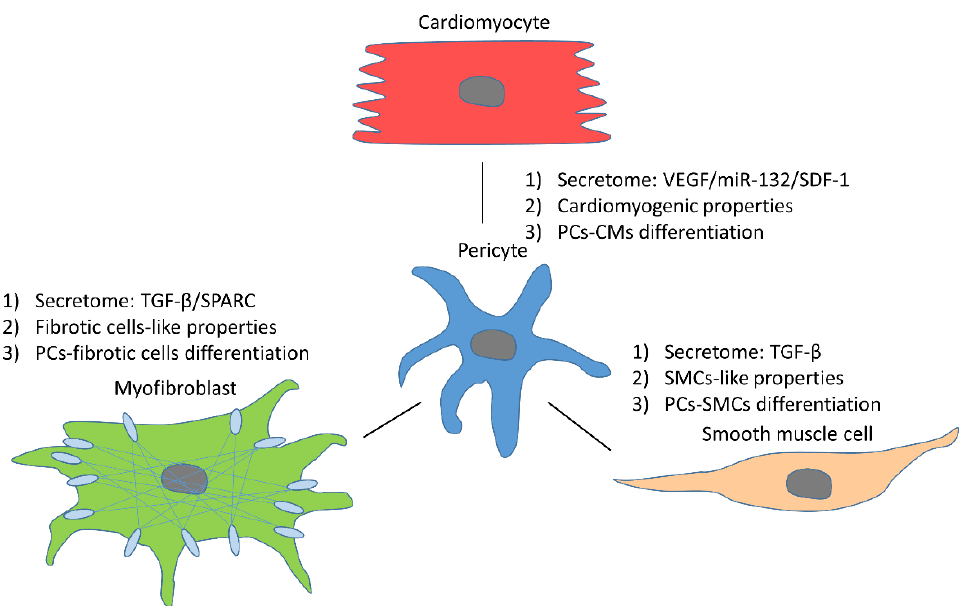
Figure 2. Interactions and differentiation between pericytes and their adjacent cells. ( 1 ) Cardiomyocytes. Through secreting VEGF and miR-132, pericytes could induce survival responses in cardiomyocytes. Moreover, stromal cell-derived factor-1 (SDF-1) from pericytes activates the mobilization of stem cells, benefiting cardiomyogenesis. Furthermore, some pericytes, sharing the same origin of epicardium with cardiomyocytes, were found to function as cardiomyocytes because of their myogenic capacity. Lastly, some immature cardiomyocytes are differentiated from pericytes. ( 2 ) VSMCs. Pericytes could produce TGF- β that is responsible for the differentiation and proliferation of VSMCs. In addition, some pericytes also show SMCs-like properties due to expression of actin and myosin ( α -SMA). Likewise, because of the PC–SMC transition, pericytes can be defined as one main source of VSMCs. ( 3 ) Myofibroblasts. Pericyte-derived TGF- β and SPARC could regulate the ECM. Other than enhancing the ECM via the secretome, type-I pericytes could produce the ECM directly. Moreover, PC – myofibroblast differentiation contributes to fibrogenesis.